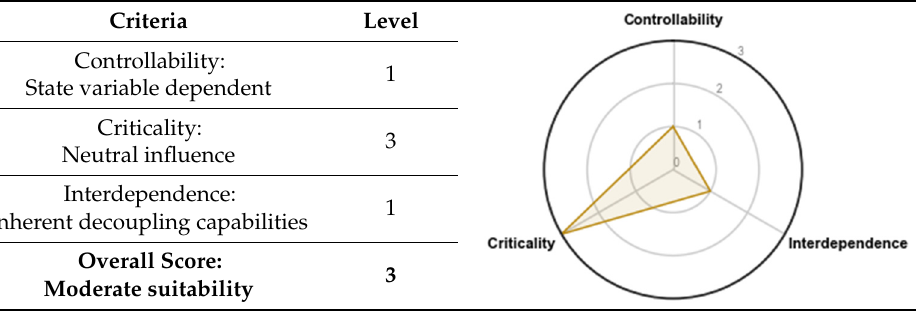
Table 6. Suitability analysis of the chilled water system (left: score, right: radar graph). Criteria